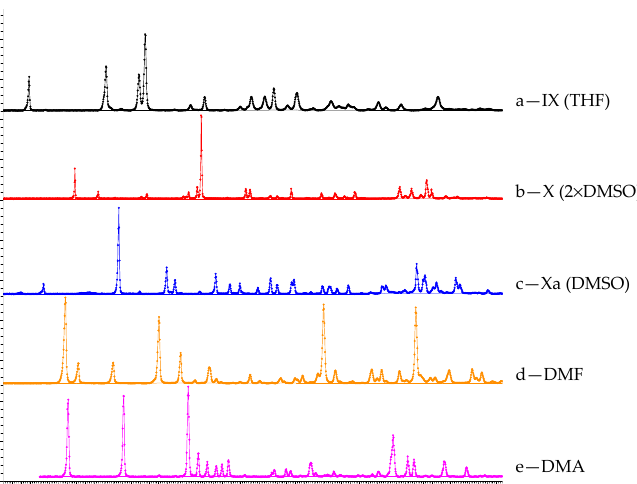
Figure 3. Raw XRPD data for solvated Eltrombopag free acid species: ( a ) Form IX; ( b ) Form X; ( c ) Form Xa; ( d ) DMF solvate;